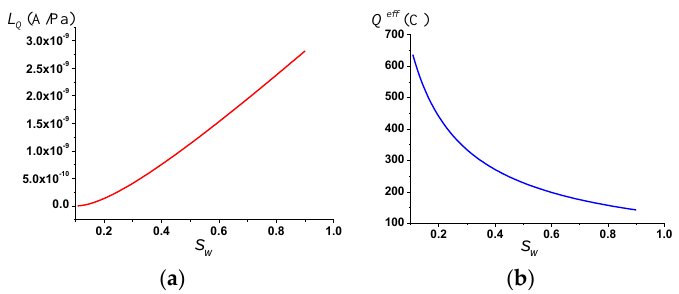
Figure 6. Effect of water saturation (time-harmonic case): ( a ) streaming current coupling coefficient; ( b ) effective net residual charge density.